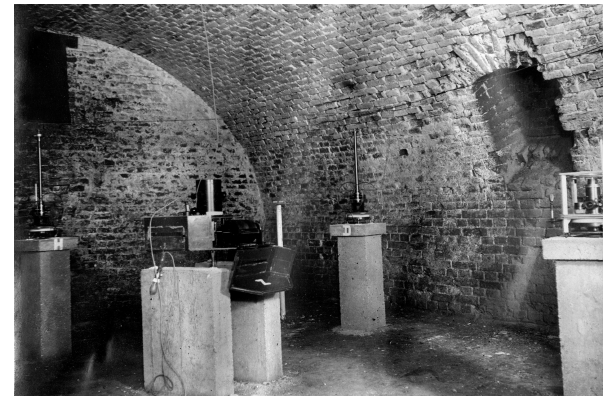
Figure 13. Interior of the Maisacher Hütte, where pillars for the instruments for absolute measurements were installed later.